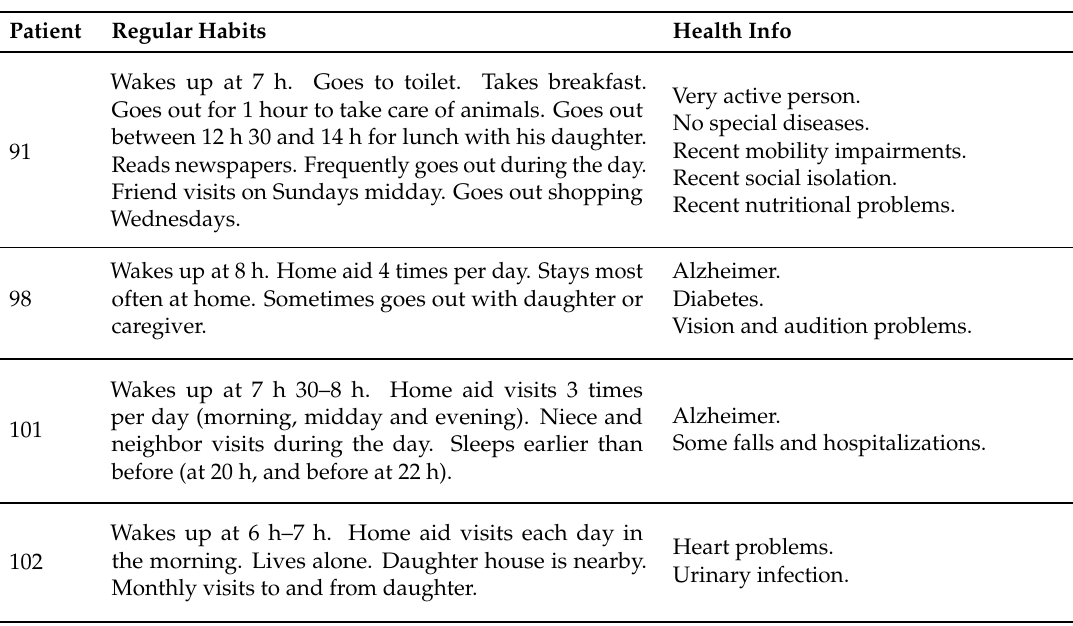
Table 2. Montpelier pilot site participants habits and health status.